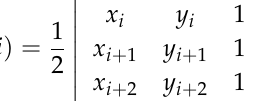
Figure 7. Poincaré plot showing the triangles for calculating CCM. The Poincaré plot is considering a lag τ